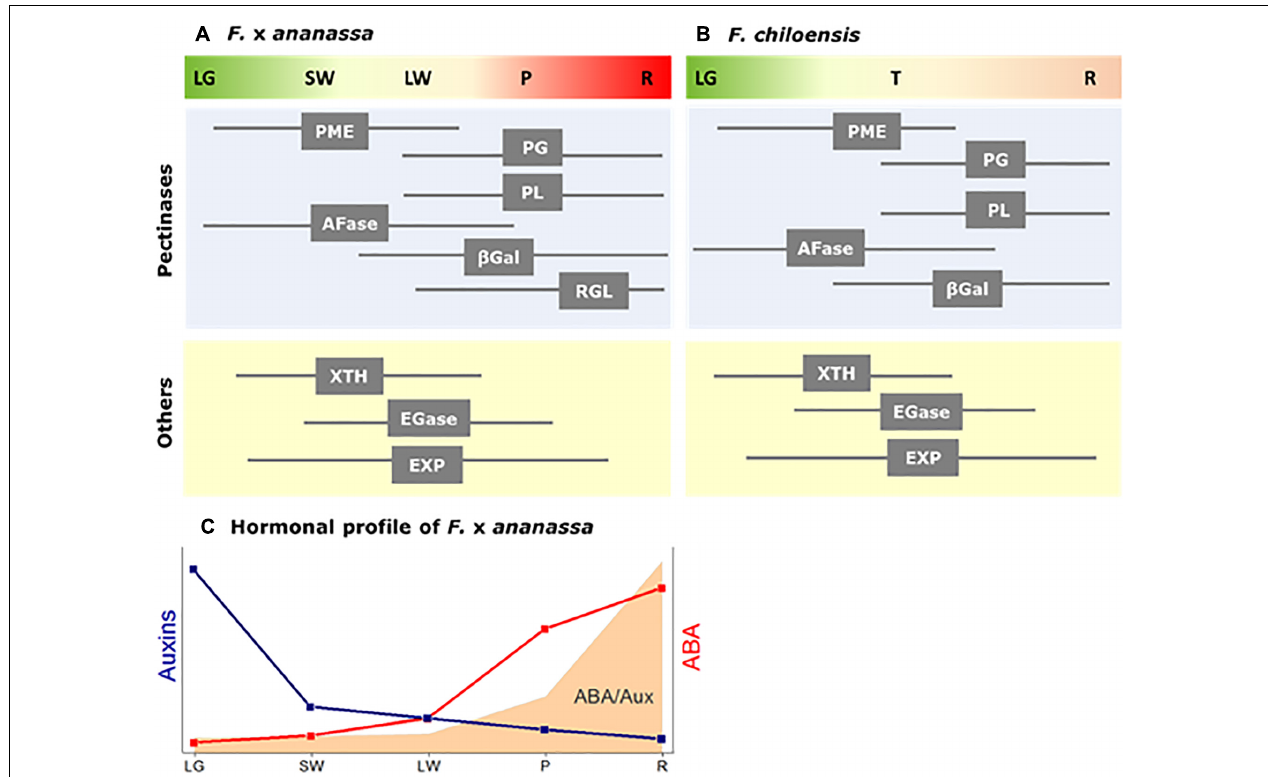
FIGURE 1 | Diagram showing the temporal expression profile of cell wall degrading genes during ripening development of two strawberry fruit species: (A) F. × ananassa , and (B) F. chiloensis . Cell wall degrading enzymes correspond to Pectin methylesterase (PME), α -Arabinofuranosidase (AFase), Polygalacturonase (PG), Pectate lyase (PL), β -Galactosidase ( β Gal), Xyloglucan endotransglycosilase/ hydrolase (XTH), Endoglucanase (EGase), Expansins (EXP) and Rhamnogalacturonan I lyase (RGL). Fruit stages for F. × ananassa correspond to: LG, large green; SW, small white; LW, large white; P, pink/turning; R, red. Fruit stages for F. chiloensis correspond to: LG, large green (large size fruit with red achenes); T, turning (large size fruit with white receptacle and red achenes); and R, ripe fruit (full size fruit with pink receptacle and red/brown achenes). (C) Scheme showing changes in auxins and ABA levels in F. × ananassa fruit; in gray the ABA/AUX ratio (adapted from Symons et al.,